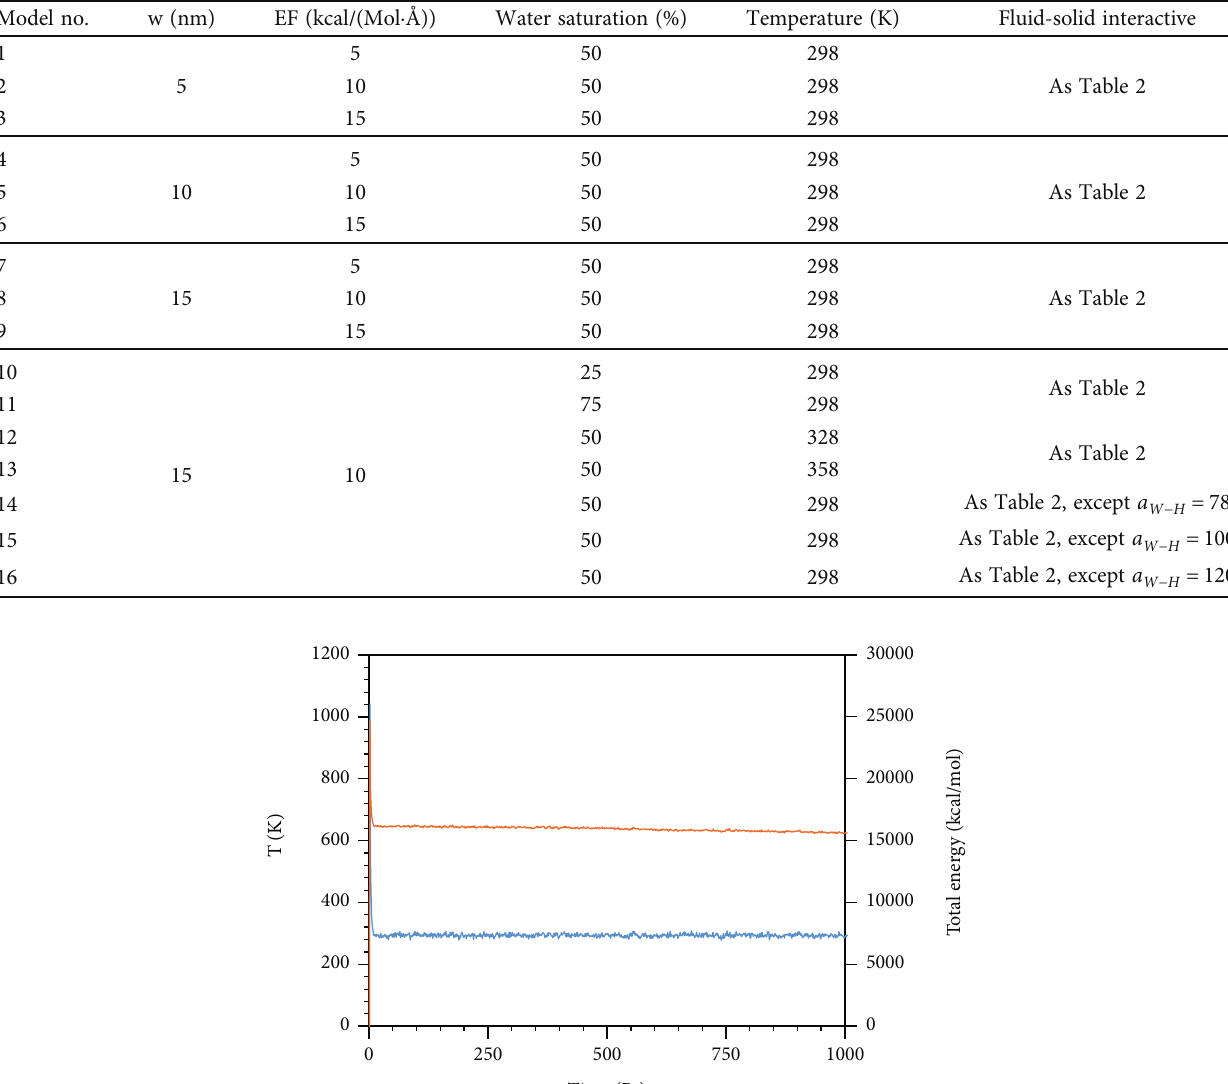
Table 3: Parameters of fl ow models.